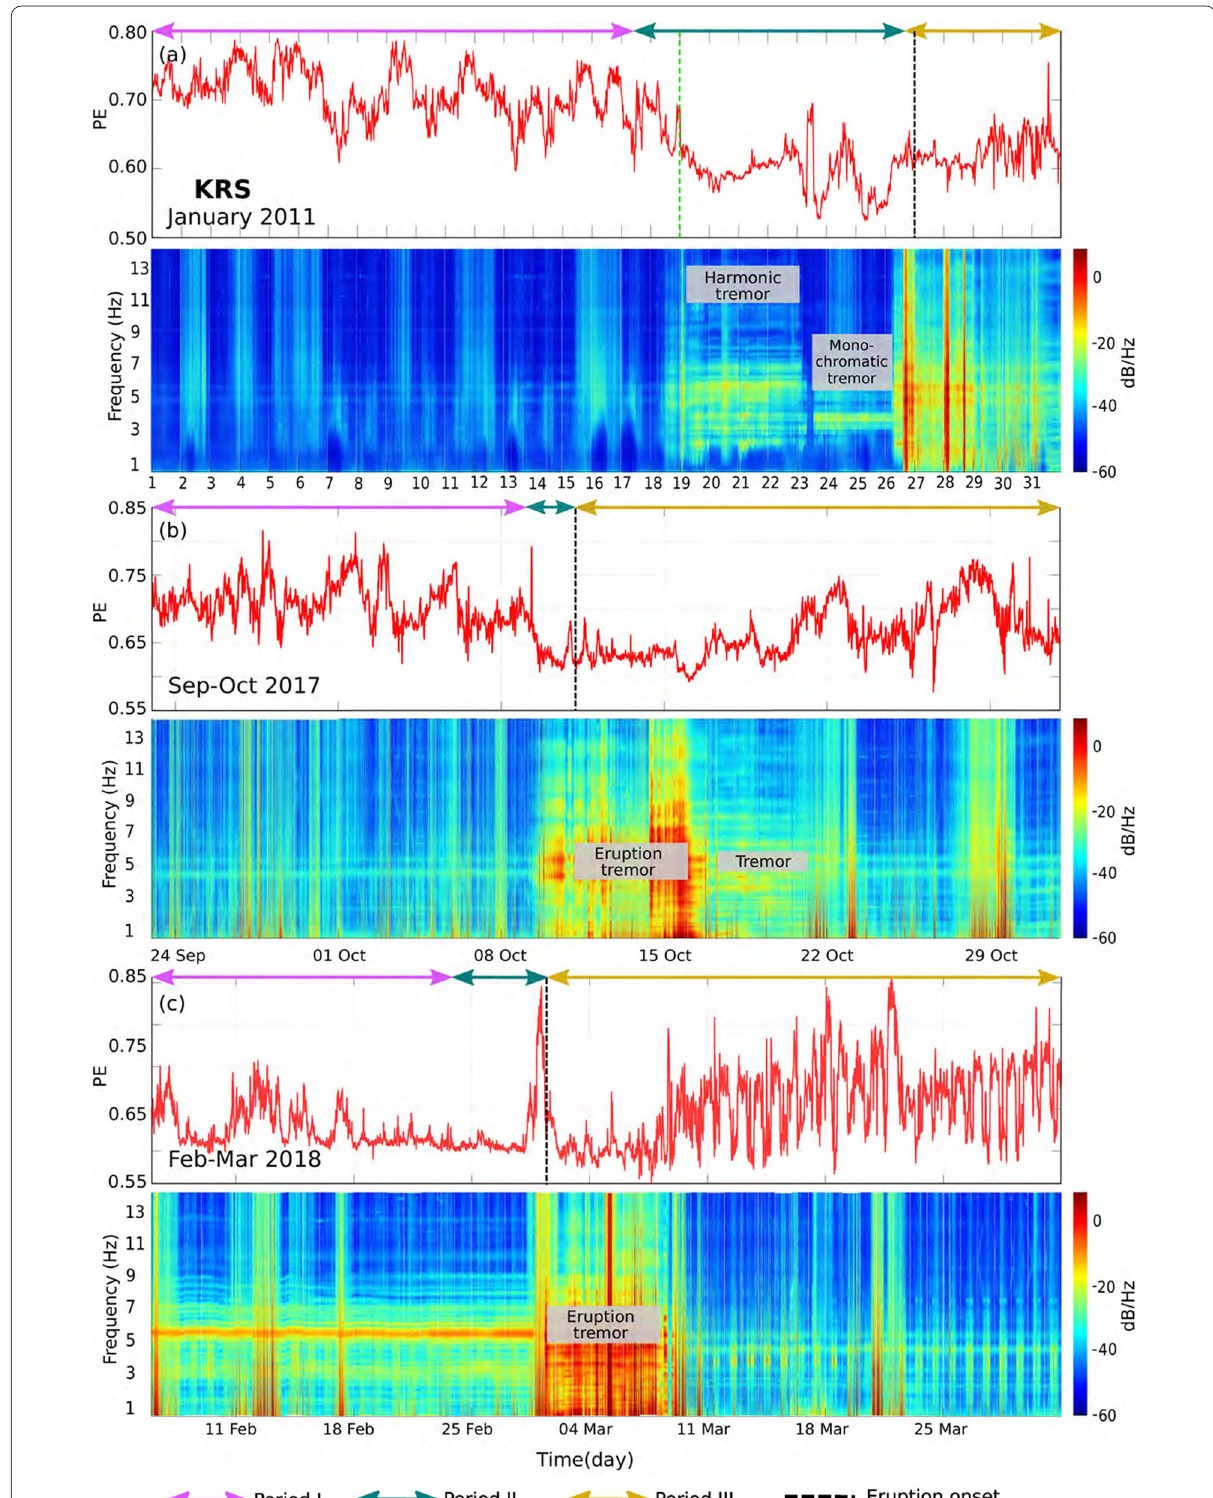
Fig. 5 Same as in Fig. 2 for station KRS. All other symbols are the same as in Fig.